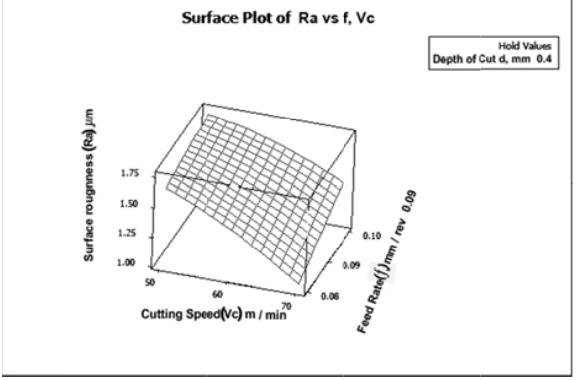
Figure 6. 3D Surface plot of R a vs. V c and f